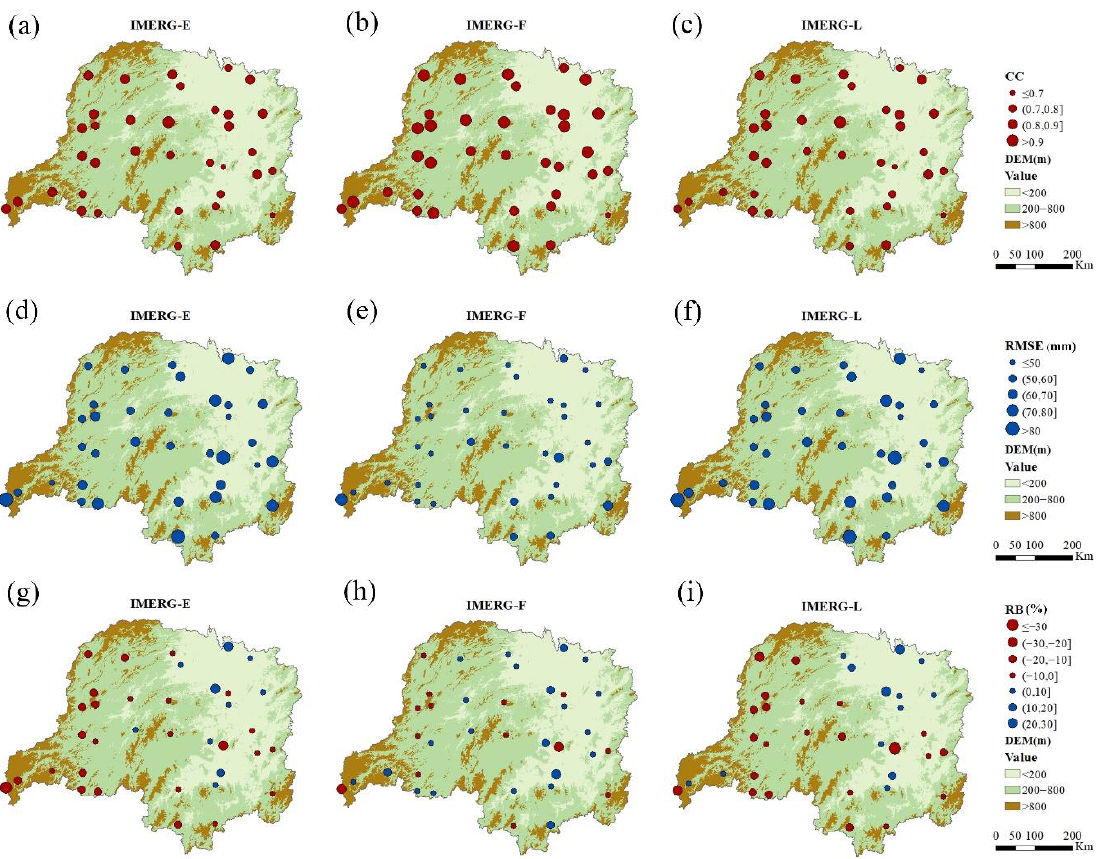
Figure 5. Spatial distribution of correlation coefficient ( a – c ), root mean square error ( d – f ), and relative bias ( g – i ) between IPPs and gauged observation at monthly time scale from 2015 to 2020 in the Dongting Lake basin.